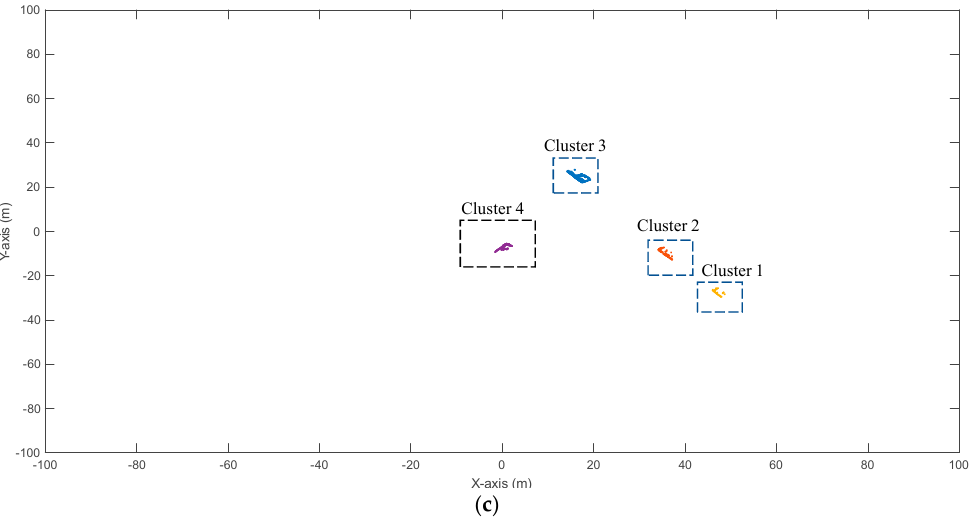
Figure 9. Point clustering: ( a ) Before point clustering, ( b ) Revised density-based spatial clustering of applications with noise (DBSCAN), ( c ) Proposed method.